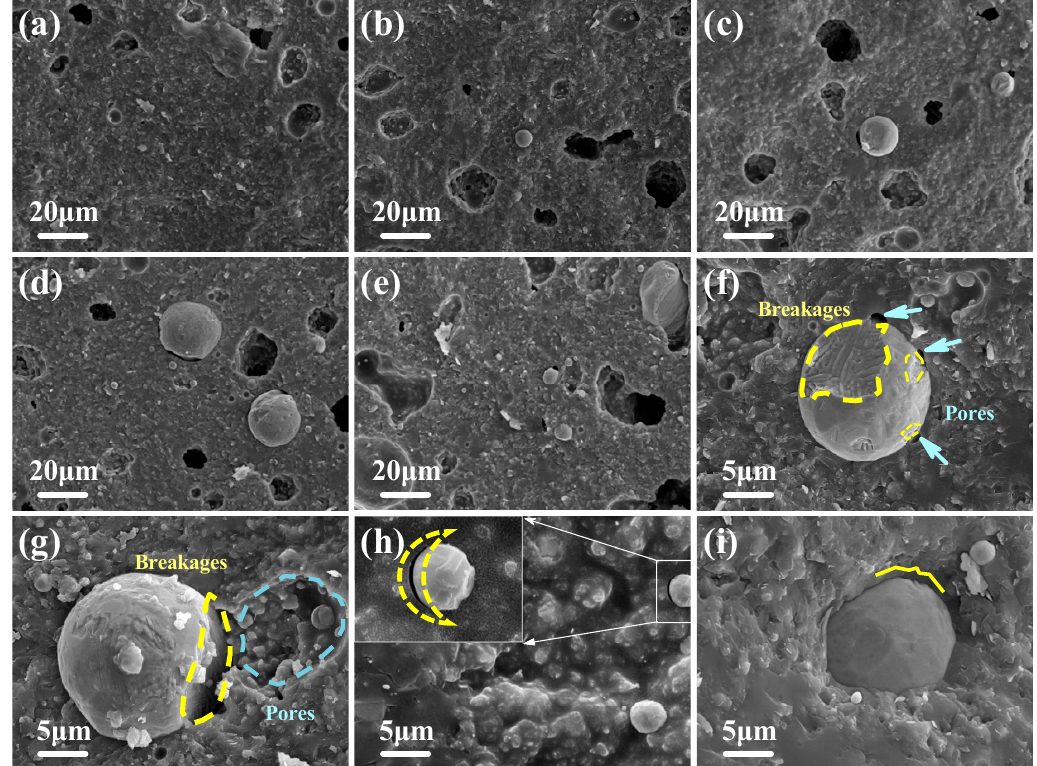
Figure 7. Microstructure and porosification behavior of TC composites, ( a ) TC2, ( b ) TC4, ( c ) TC6, ( d ) TC8, ( e ) TC16, ( f ) alloy powder with breakages, ( g ) voids accompanied by the alloy breakage, ( h ) crescent-shaped gap, and ( i ) dense